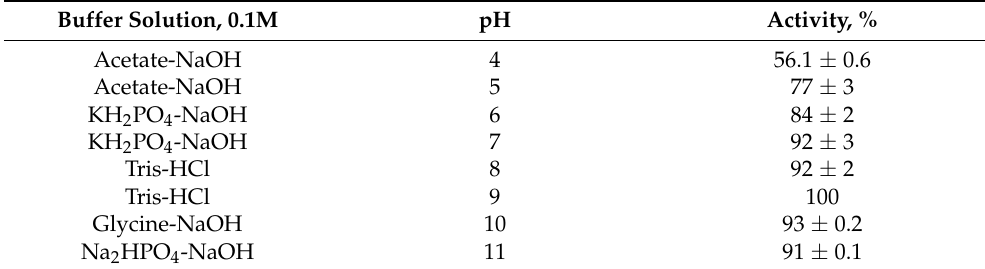
Table 4. Michaelis–Menten parameters of MDH-His 6 -tag in reactions with different substrates ( p = 0.95; n = 3). Reaction rates were measured at 30 ◦ C, pH 9.0. Substrate Apparent K M , mM Vmax, U/mg Protein Activity, % Methanol 0.36 ± 0.07 4.2 ± 0.2 100 Ethanol 0.61 ± 0.06 2.9 ± 0.1 79 Butanol-1 1.9 ± 0.2 2.7 ± 0.1 71 Amyl alcohol 1.4 ± 0.1 2.8 ± 0.1 67 Formaldehyde n.a. n.a.